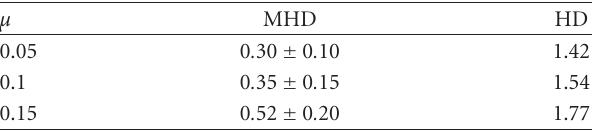
Table 1: The mean Hausdor ff distance (MHD) and the Hausdor ff distance (HD) (in μ m) between a gold standard of real data and the segmented surfaces using (5). HD and MHD are averaged on the number of nuclei in the subvolume. The segmentation is performed using di ff erent values of μ